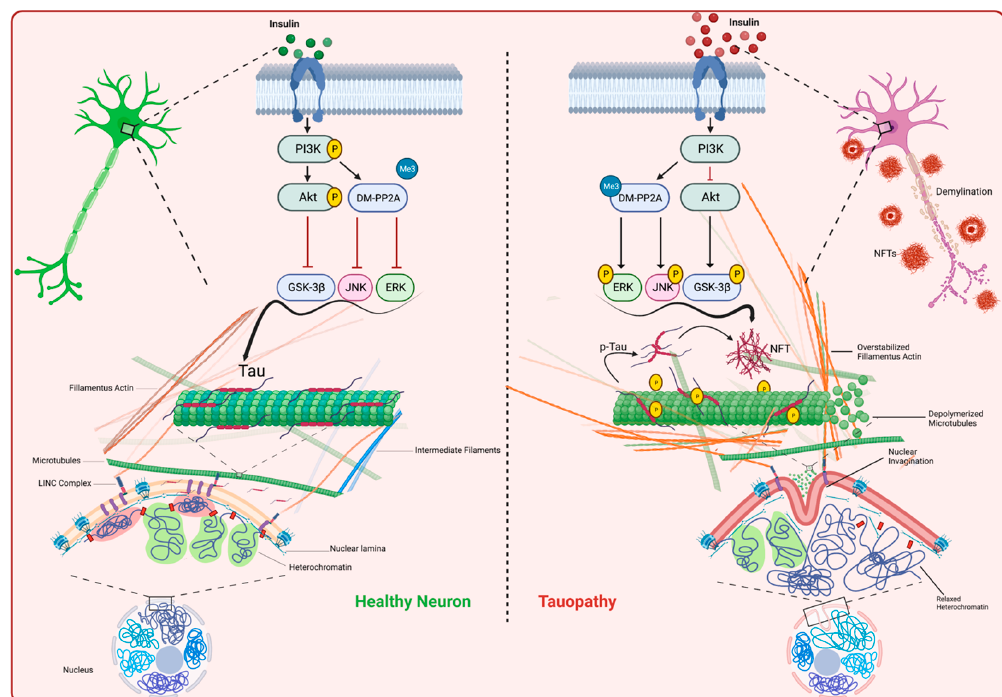
Figure 5. Pathogenic tau, upstream and downstream events (created with BioRender.com). In healthy neurons ( left ), physiologic tau is responsible for microtubule assembly and maintenance of critical cellular components such as the cytoskeleton, the nucleoskeleton and DNA integrity. Under pathologic conditions ( right ), PTMs can alter tau functions. For instance, activated ERK, JNK or GSK3 β induces tau hyperphosphorylation, which is the main trigger of tau aggregation and NFT formation in the neurons. Consequently, this may lead to microtubule disassembly, actin overstabilization and nuclear lamina invagination. These circumstances can dysregulate genomic DNA integrity. Moreover, extracellular release of NFTs facilitates their neuron-to-neuron transmission. These pathophysiological events ultimately result in progressive neurodegeneration.